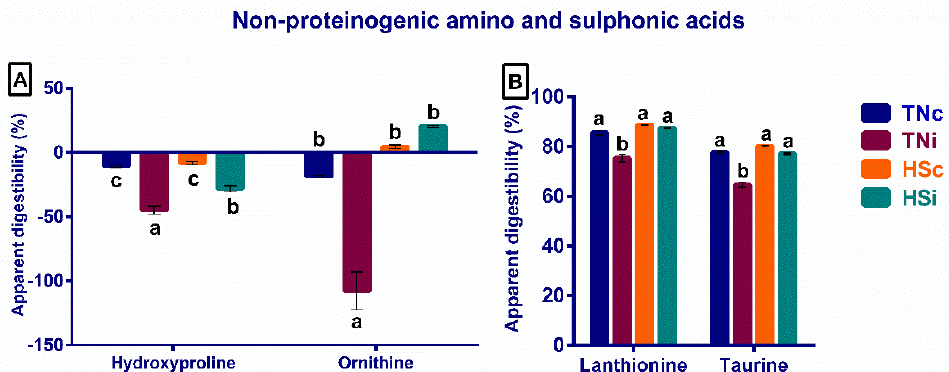
Figure 2. The apparent ileal digestibility of the non-proteinogenic amino acids ( A ) and sulphonic acids ( B ) at 6 dpi of E. maxima -infected chickens raised under thermoneutral (TNi) and heat-stress (HSi) conditions, as compared to uninfected control chickens raised under thermoneutral (TNc) or heat-stress (HSc) conditions (N = 6). Significant differences ( p < 0.05) are depicted by different letters. The error bars represent the